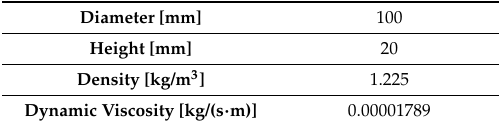
Table 1. Properties of the surrounding air domain.